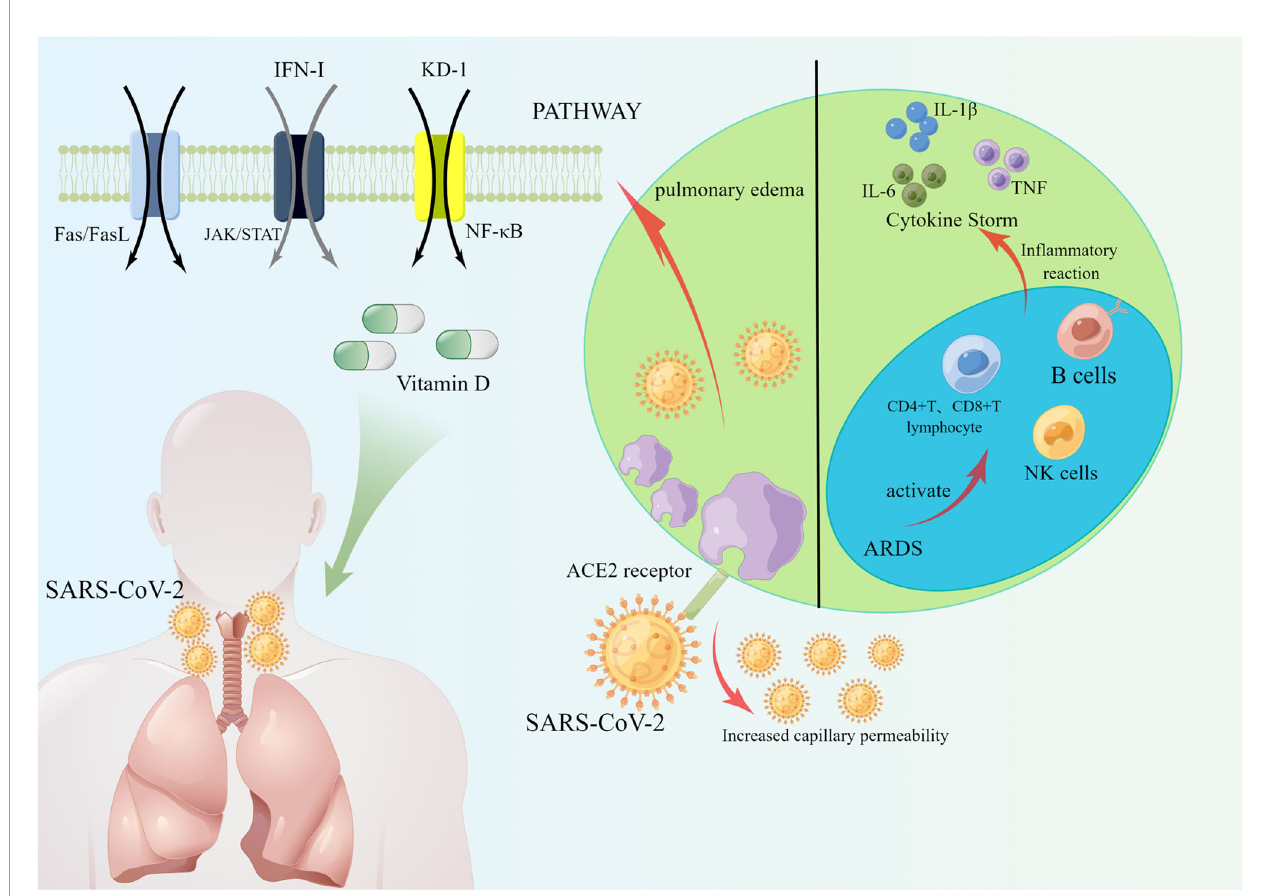
FIGURE 2 | SARS-CoV-2 enters cells through ACE2 receptors, and ACE2 increases capillary permeability, allowing more SARS-CoV-2 to enter cells, which in turn induces the development of ARDS. COVID-19 activated an immune response in which NK cells, CD4+ T lymphocytes, CD8+ T lymphocytes and B cells reacted immunologically in COVID-19 patients, causing the production of cytokines IL-6, IL-1 b , TNF, etc. Reducing COVID-19 infection and prevent ARDS through Fas/FasL pathway, JAK/STAT pathway, and NF- k B pathway. Helping patients to prevent and treat COVID-19 by increasing type I interferon and vitamin